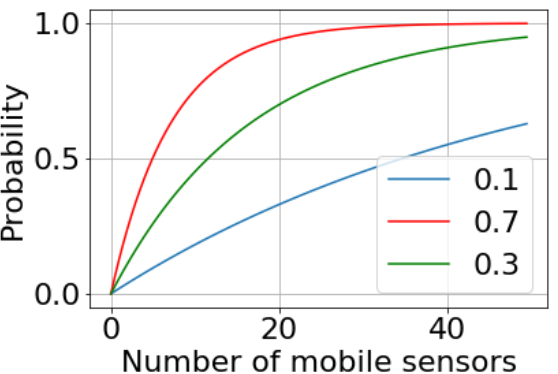
Figure 3. Dependence in the probability of detecting contamination within a specified time for different numbers of mobile sensors.